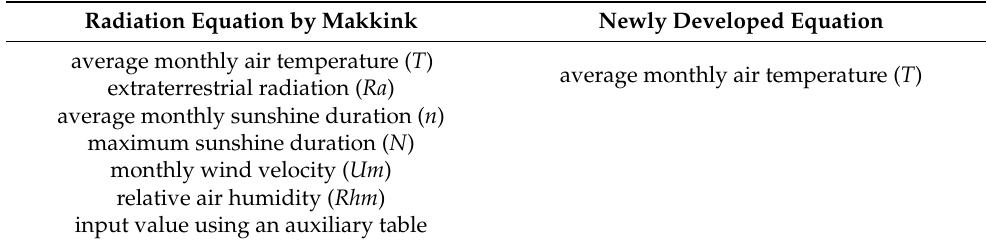
Table 4. Comparison of input parameters between the radiation equation by Makkink and the newly developed equation. Figure 1. Overview of the used research design (based on Weiss et al., 2019 [19]) .